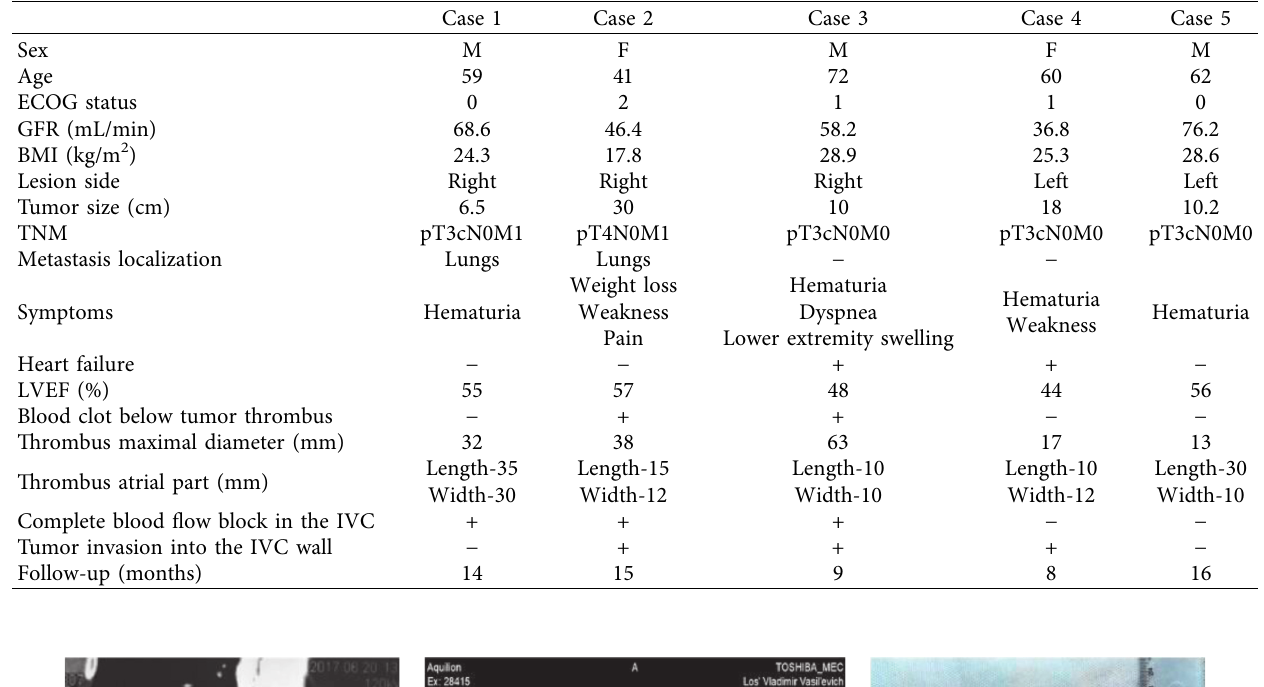
Table 1: Characteristics of patients and tumors with atrial